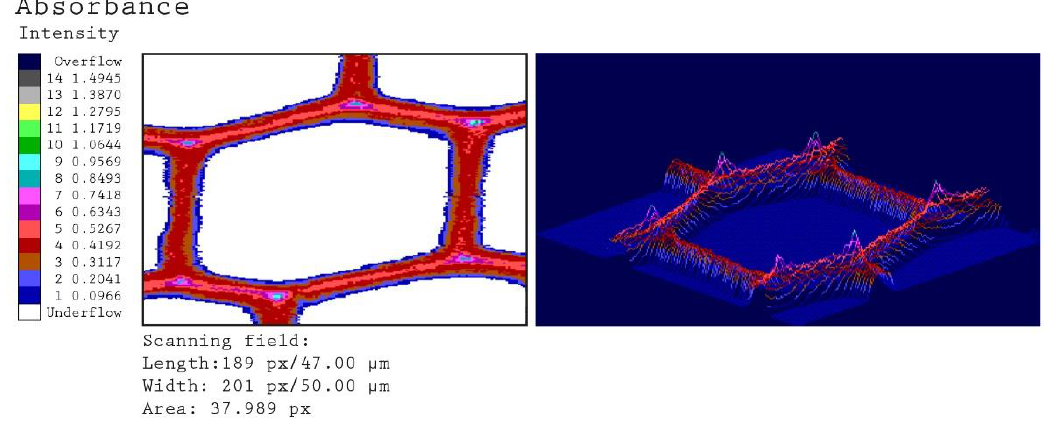
Figure 5. Representative UV microscopic image profiles of an individual tracheid from reference particle. The colored scale indicates the different UV-absorbance values at a wavelength of 280 nm.